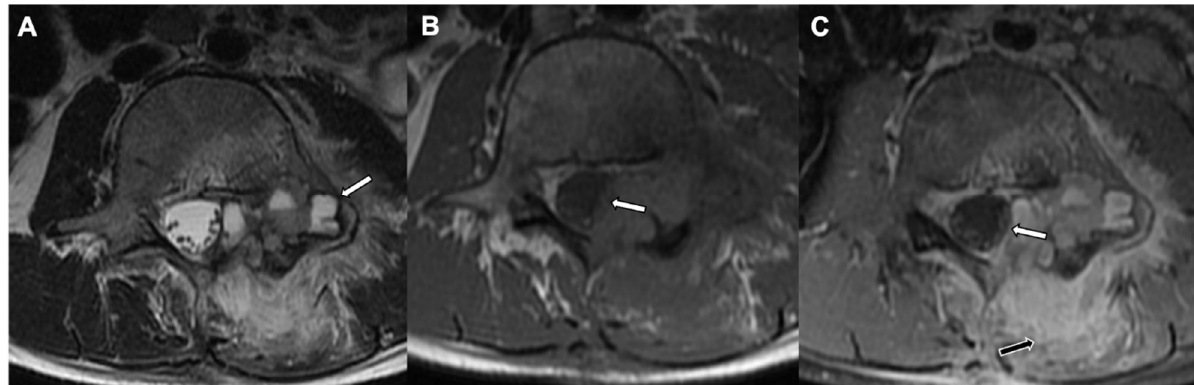
Figure 8. Osteoblastoma with secondary aneurysmal bone cyst formation in an 11-year-old female: MRI of the lumbar spine shows a well-defined expansile lesion involving left lamina and pedicle with fluid—fluid levels (white arrow) on the axial T2-weighted sequence ( A ). The lesion encroaching in the spinal canal causing mild abutment of the traversing nerve fibers is seen on the axial T1-weighted sequence ( B ) and the axial T1-weighted postcontrast image ( C ). A note is also made of associated diffuse moderate to advanced left posterior paraspinal muscle strain with enhancement (black arrow) and mild left psoas muscle edema.